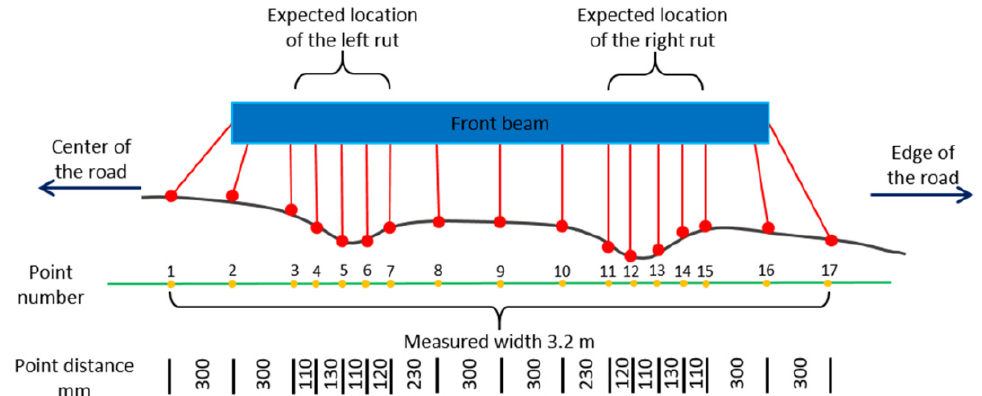
Figure 1. Measurement principle of laser profilometer for rutting measurements. The measurement area is determined by the Finnish standard in the way that laser beams 3–7 should locate at the left rut. Such a system can cover a 3.2-m-wide area of the pavement, with point spacing of 11–30 cm across the road [20].